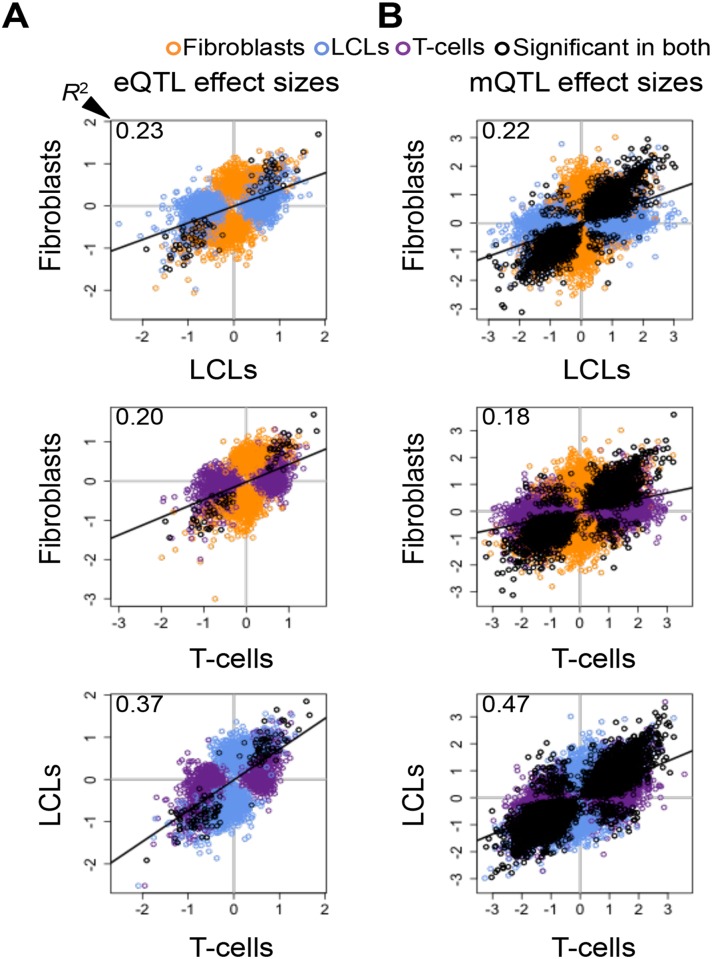
Cell-type specific genetic effects on gene expression and DNA methylation.Effect sizes of expression Quantitative Trait Locus (eQTL) (A) and methylation QTLs (mQTL) (B) unions for each pair of cell-types. Effect size is measured as the difference in medians of scaled expression or scaled methylation level (β-value) between heterozygous individuals and the homozygous individuals for the major allele. Hence, effect sizes are quantified in terms of number of expression or methylation standard deviations changed by an allele modification for eQTLs and mQTLs, respectively. Effect sizes are significantly correlated among all cell-types (Pearson’s correlation P < 2.2E-16). Coefficient of determination R
2, reflecting the proportion of effect size variance in one cell-type explained by the other cell-type, is shown in the top left corner of each plot (S1 Table). SNP-exon pairs or SNP-CpG pairs that are significant in both tissues at 10% FDR are depicted in black, whereas associations significant in only one of the two cell-types compared are in orange (fibroblasts), blue (LCLs) and purple (T-cells). The R
2 and the spread of the scatter plots show there is a large amount of tissue-specific genetic effects on gene expression and DNA methylation.